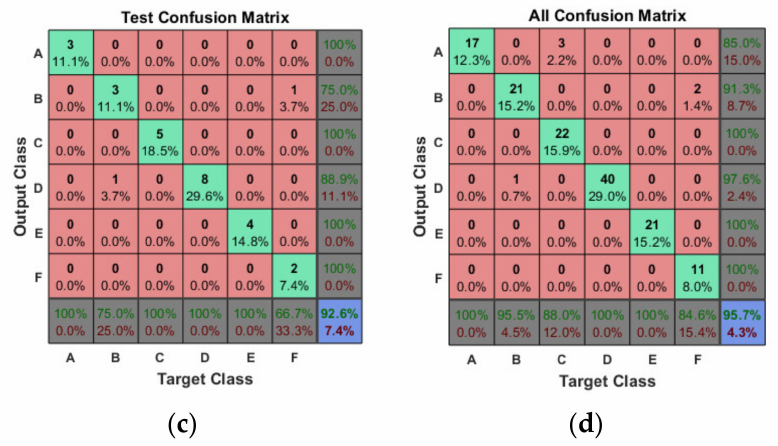
Figure 20. The confusion matrices of ANN trained with LCC feature set: ( a ) training confusion matrix, ( b ) validation confusion matrix, ( c ) testing confusion matrix, and ( d ) overall confusion